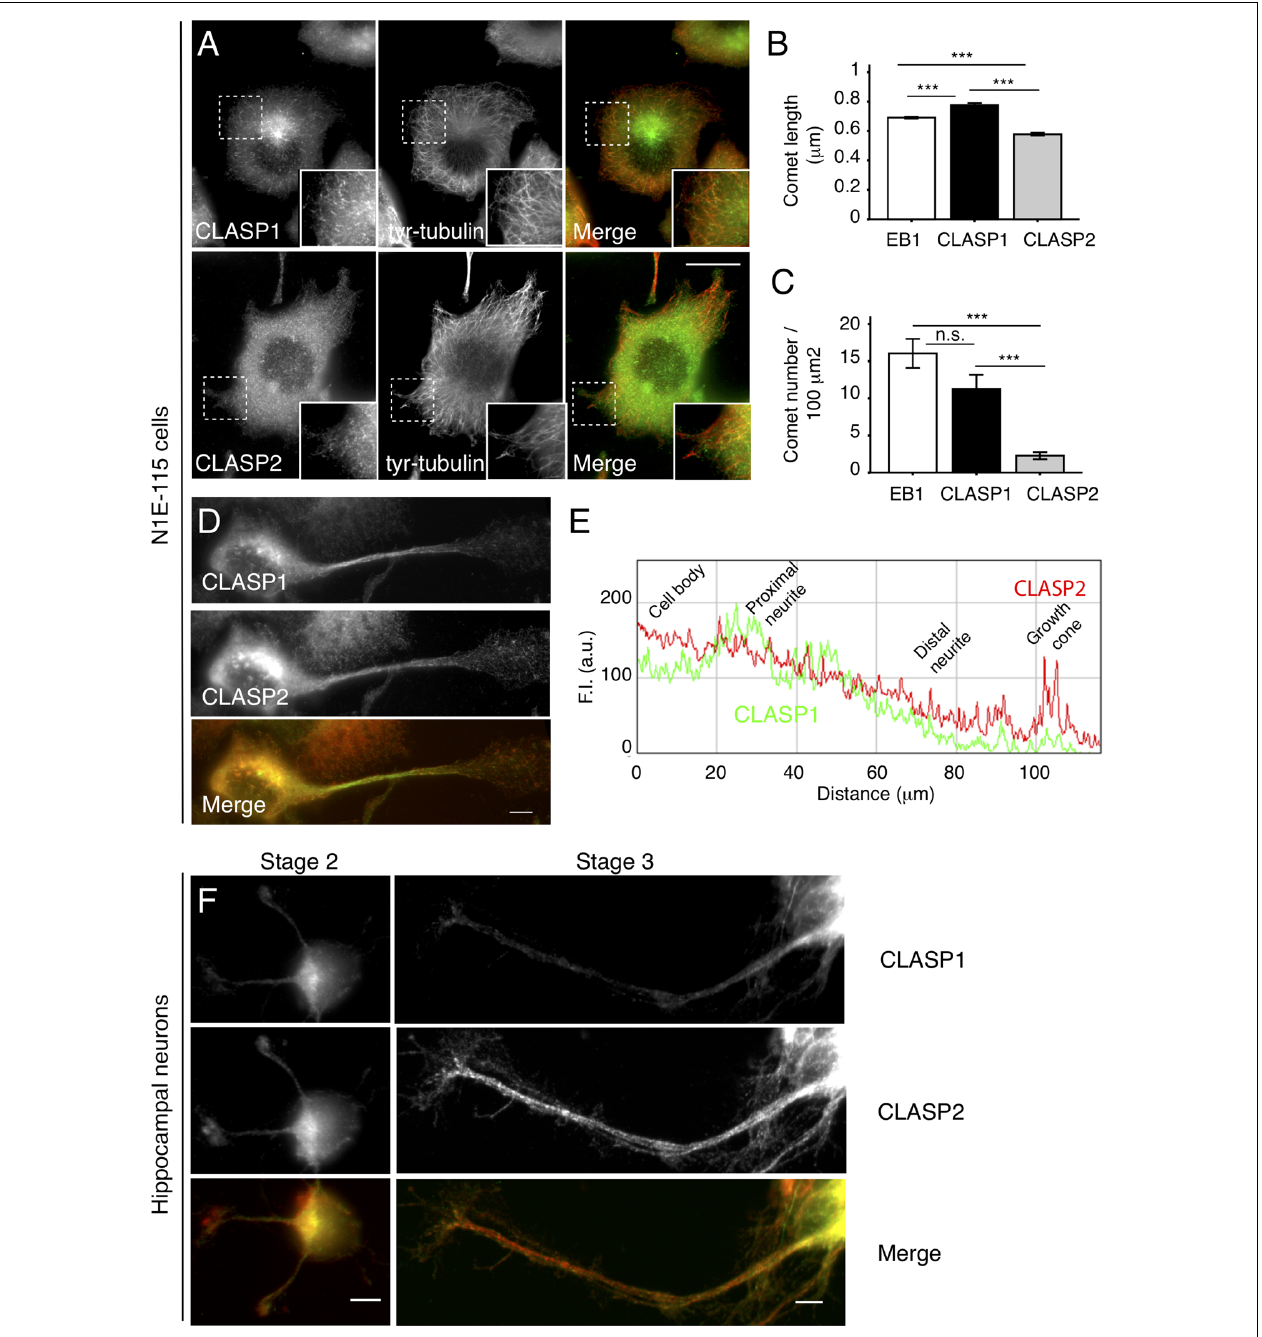
FIGURE 1 | Intracellular distribution of cytoplasmic linker associated protein 1 and -2 (CLASP1 and -2) in differentiating N1E-115 cells and young primary hippocampal neurons (HNs). (A) CLASP1 and CLASP2 distribution in flattened N1E-115 cells. Fluorescence images of cells that were serum-deprived overnight, fixed and stained with antibodies against CLASP1 (upper left panel, green in the merged image) or CLASP2 (lower left panel, green in the merged image) and tyrosinated-tubulin (middle panel, red in the merged images). Scale bar = 20 µ m. Insets show protein localization in more detail. (B,C) Quantification of microtubule (MT) plus-end staining (comets). Comet length (B) and density (C) of MT plus ends stained with end binding 1 (EB1), CLASP1 or CLASP2 antibodies, were measured in immunofluorescence (IF) images such as depicted in panel (A) . Comets were counted in 3–4 squares of 100 µ m 2 per cell. EB1: n = 3566 comets/24 cells; CLASP1: n = 699 comets/19 cells; CLASP2: n = 962 comets/48 cells. ANOVA tests were performed in (B,C) . Standard error of the mean (SEM) is depicted in each bar graph. (D) Localization of CLASP1 and -2 in neurite-bearing N1E-115 cells. Cells were fixed and stained with antibodies against CLASP1 (green in merge) and -2 (red in merge). In (E) a plot is shown with the fluorescence intensity (FI) distribution of CLASP1 (green) vs. CLASP2 (red) in process-bearing cells, from the cell body to the growth cone. (F) Localization of CLASP1 (green in merge) and -2 (red in merge) in mouse primary 1 days in vitro (DIV) HNs, at differentiation stages 2 and 3. Scale bars = 50 µ